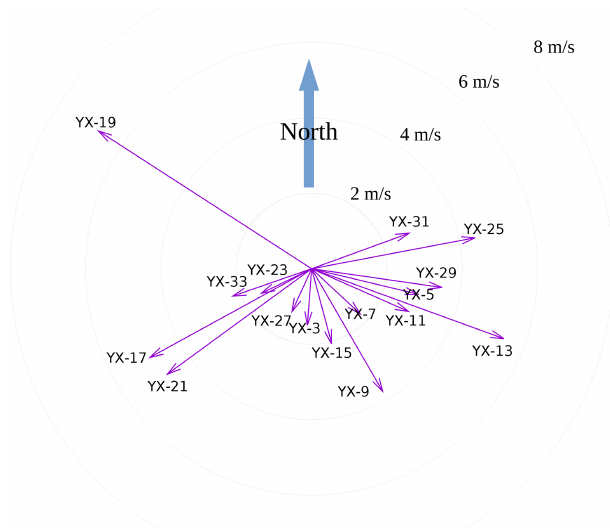
Figure C1. Vector representing local wind conditions at the sam- pling station. The length of the vector represents wind speed aver- age, and its angle indicates the average direction during each sam- pling period.